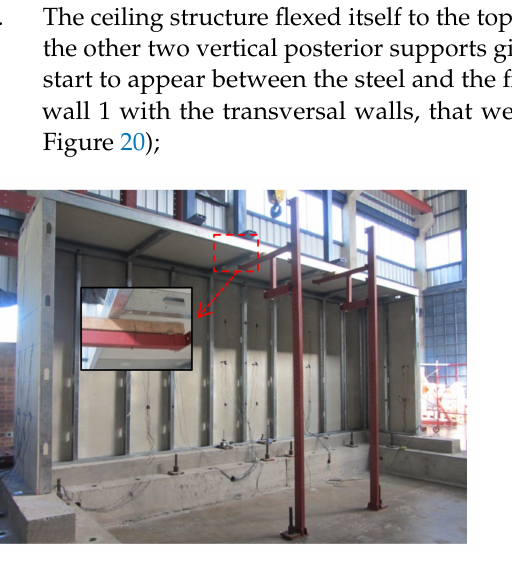
Figure 19. Elevation of the anchored profile on the east face of wall